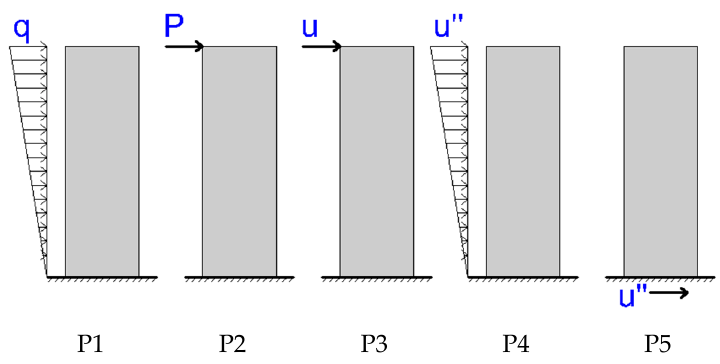
Figure 1. Graphical representation of the considered load patterns.